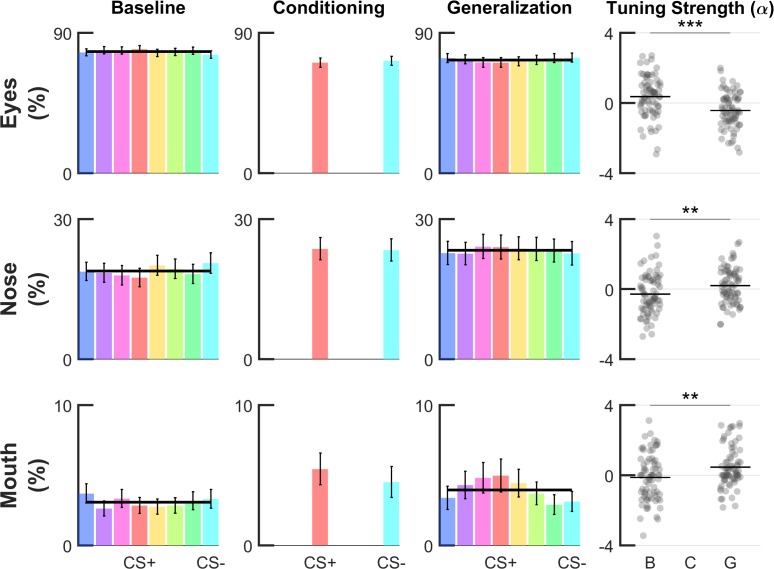
Generalization profiles on ROI-based fixation counts.Group-level fear-tuning based on percentage of fixations in a given ROI (n = 74) for different phases. Fixation count data expressed as percentages are based on three major facial regions, that is eyes, nose and mouth (see Figure 5). Responses are aligned to the CS+ of each volunteer separately (errorbars: SEM across subjects) and normalized to a mask comprising the three ROIs. Black horizontal lines or curves indicate the winning model (p<0.001, log-likelihood ratio test), that is horizontal null model or the Gaussian model. In all situations, the null horizontal model was favored by the model comparison procedure. Scatter plots show amplitude parameter α of single-subject Gaussian fits. Horizontal lines within the scatterplots depict group-level means, asterisks indicate significant differences in α (compared to baseline phase, paired t-test, ***: p<0.001, **: p<0.01).